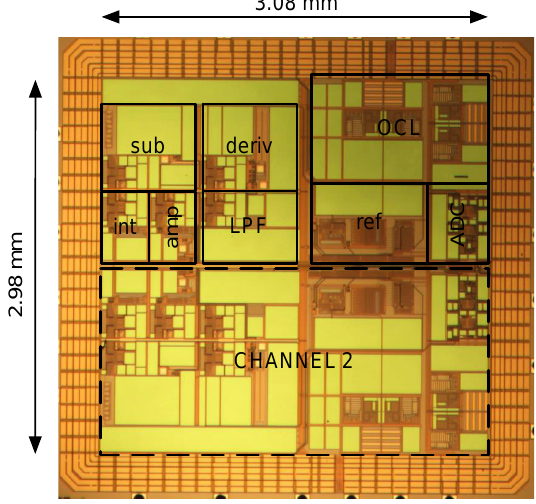
Figure 11. Chip microphotograph.